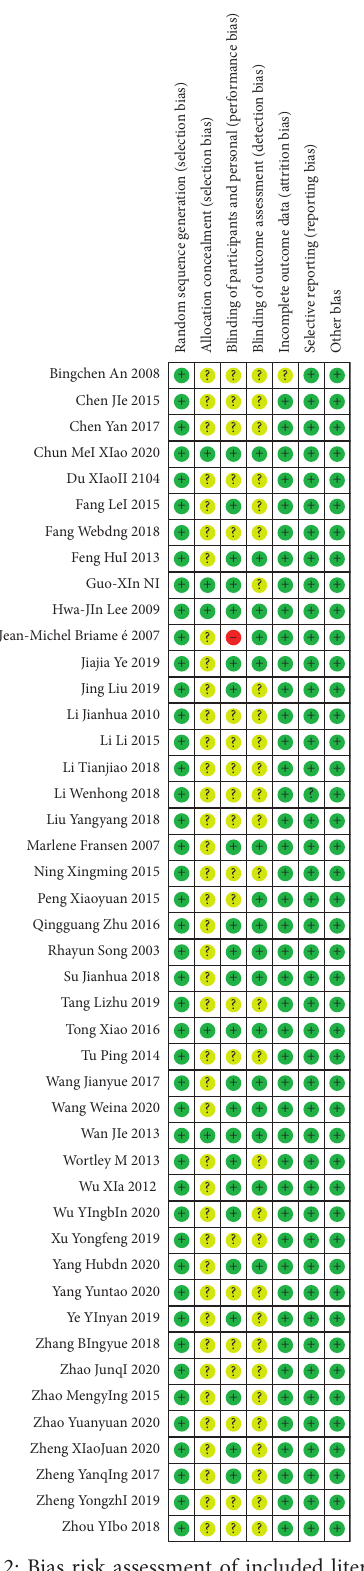
Figure 2: Bias risk assessment of included intervention of traditional Chinese exercise were signifi- cantly lower than those of the control group [MD � − 2.73, 95% CI ( − 7.15, − 1.69), P < 0.01], as shown in Figure 6. The